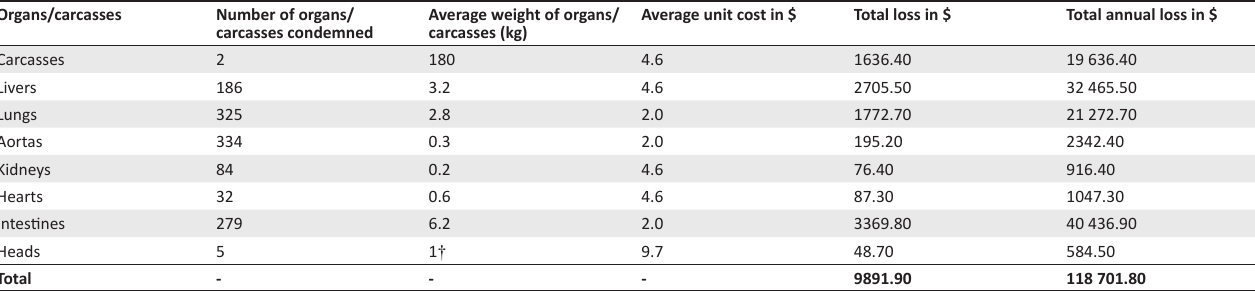
TABLE 2: Financial loss in prospective study carried out in December 2013 at Dodoma abattoir, Tanzania.